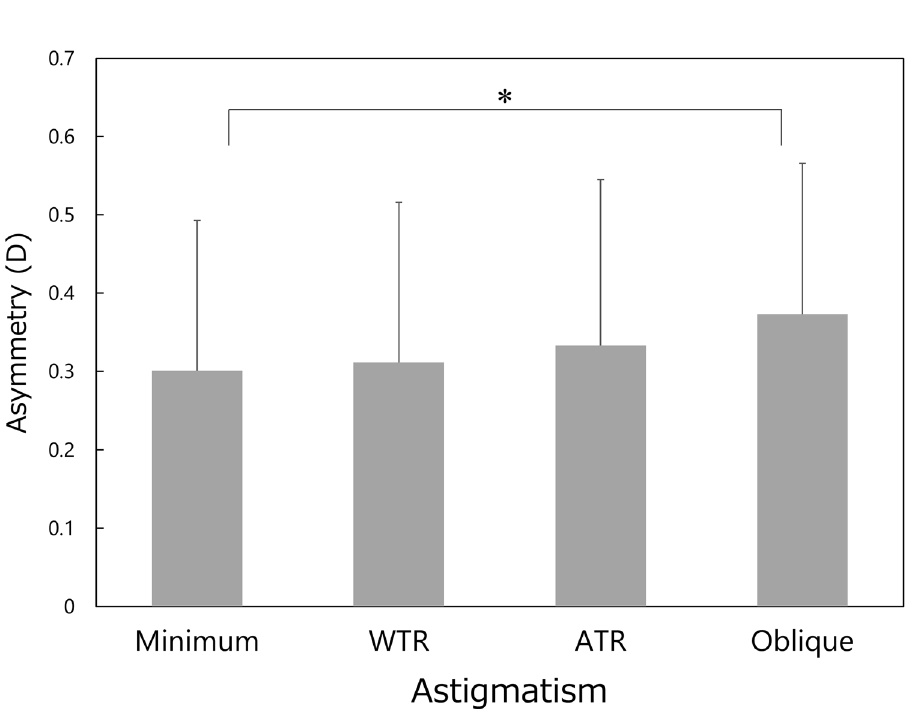
Figure 2. Comparison of asymmetry component among the four types of corneal regular astigmatism groups. Mean ± standard deviation, WTR with-the-rule, ATR against-the-rule, * P =